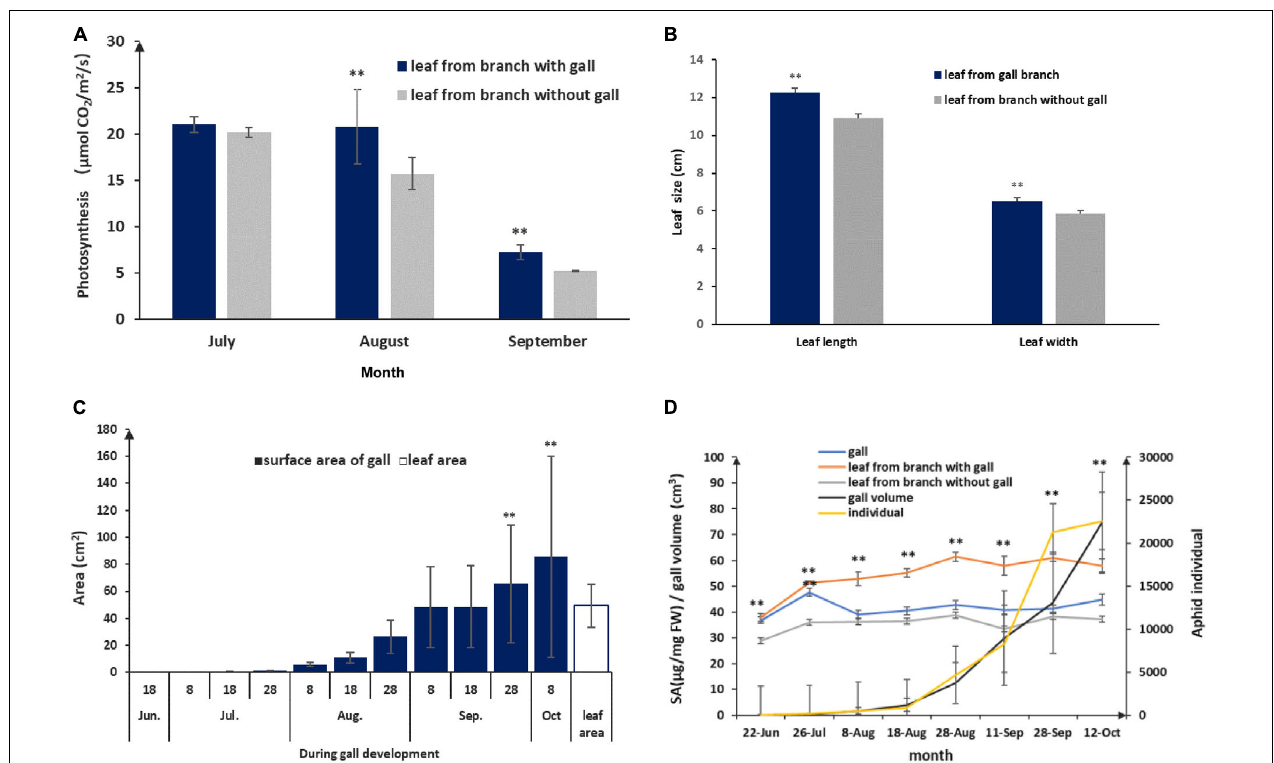
FIGURE 5 | Physiological and growing characterization of gall and leaf during gall development. (A) Photosynthesis rate comparison between leaves with a nearby gall and leaves without adjacent gall. (B) Leaf sizes of leaves without adjacent and leaves with a nearby gall in September. (C) Leaf area and area of the gall surface during gall development. (D) SA response in gall and leaf during aphid population rising and gall growth. ** represent P <